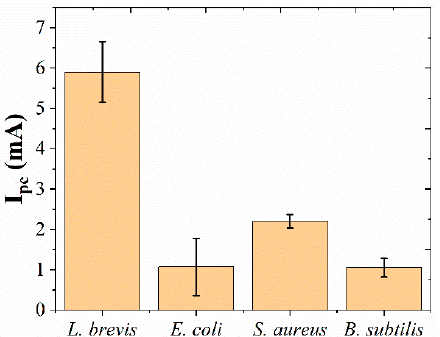
Figure 7. The specificity of immunosensor for L. brevis , E. coli , S. aureus and B. subtilis .